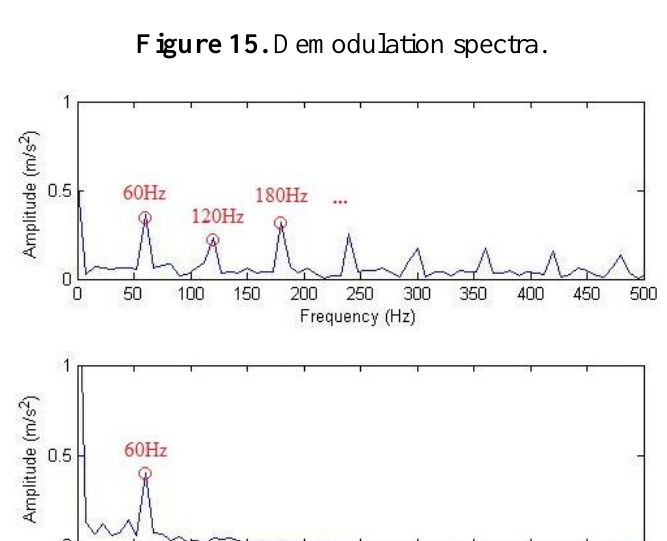
Figure 15. Demodulation